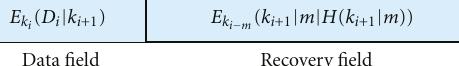
Figure 2: Packet structure augmented to include recovery informa-